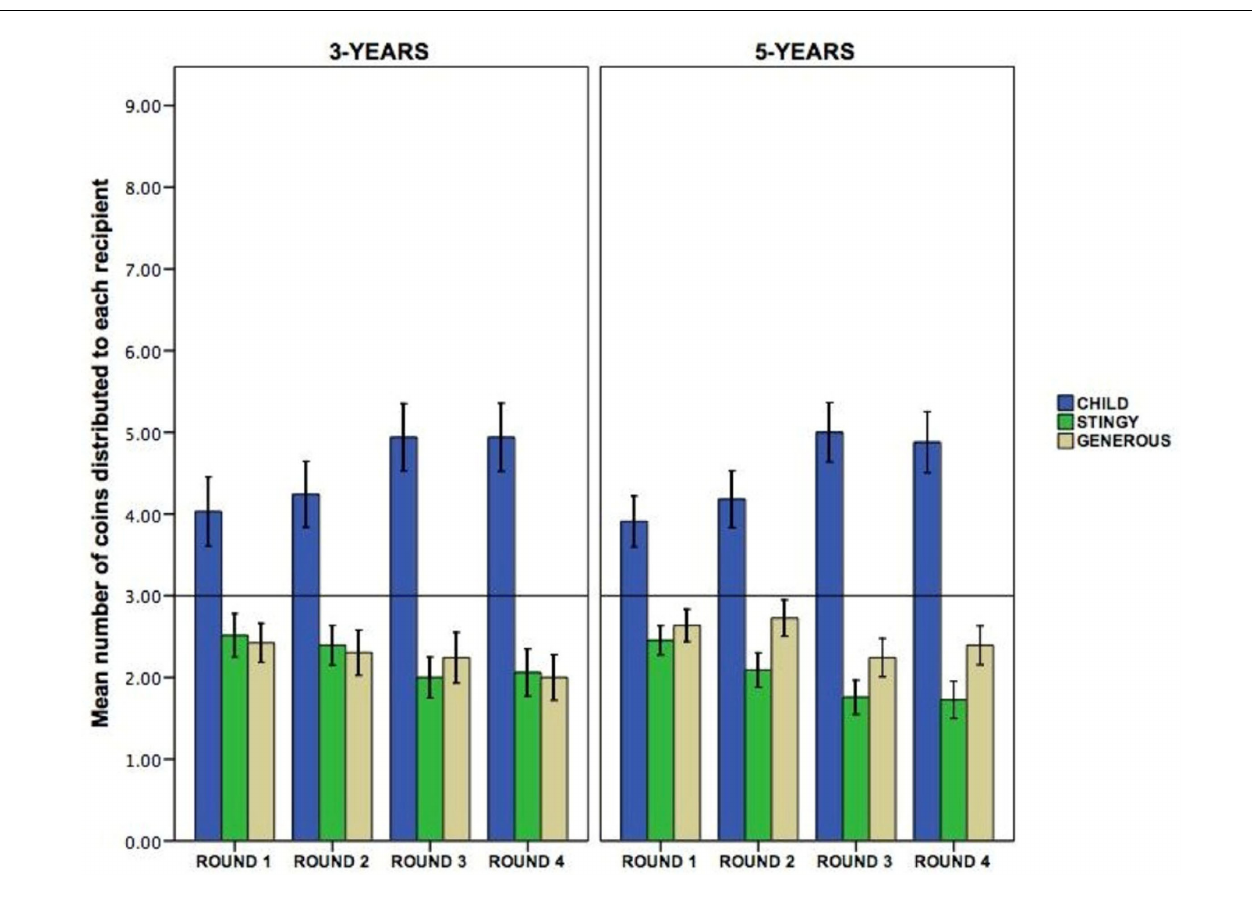
protagonist (child, stingy, and generous) as a function of round (1–4).The horizontal line represents absolute equity (three coins). Bars represent ± 1